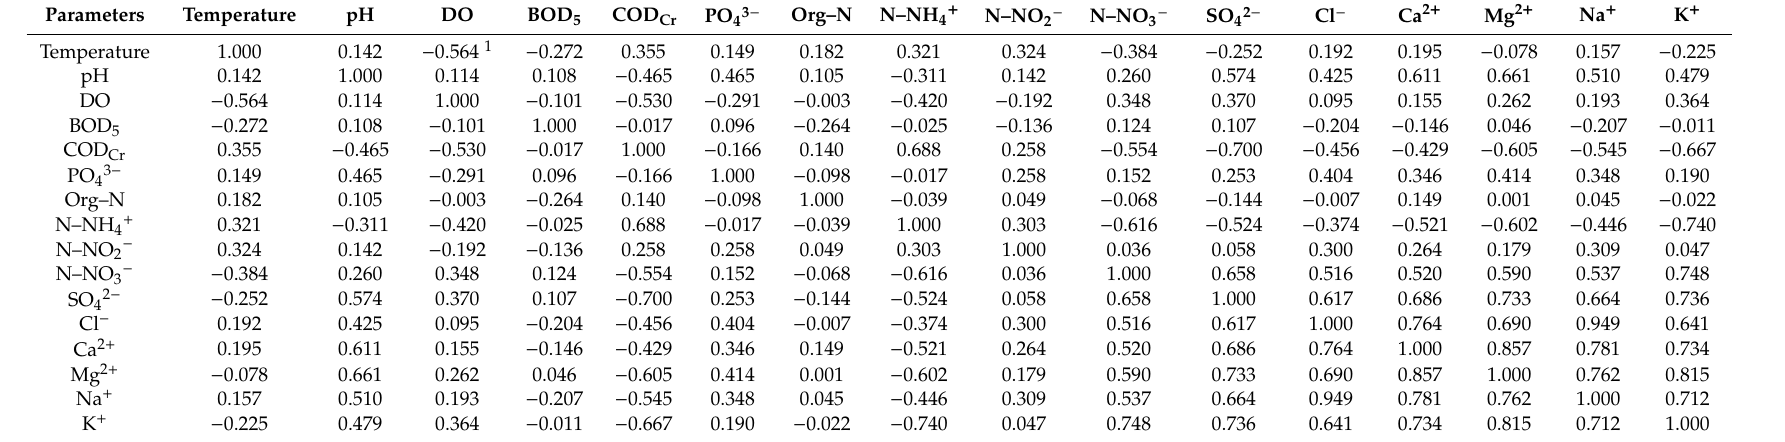
Table 4. The correlation matrix of the analyzed